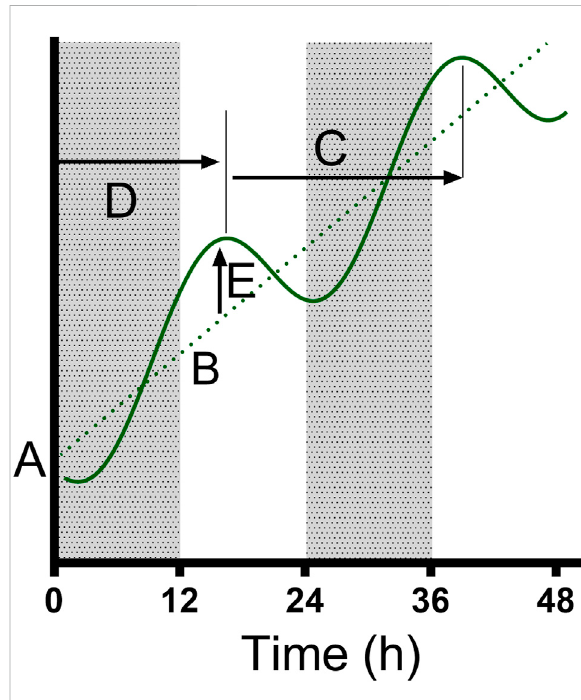
FIGURE 2 The parameters fi tted to the data. We used a model where a cosinor (solid curve) oscillates around a line (dotted line); the model was classi fi ed by the initial value (A) and gradient (B) of the line y = Bx + A, as well as the period (C) , Acrophase (time to fi rst peak, (D) and amplitude (E) of the cosinor. Where a cosinor was not preferred to a straight line, only the preferred parameters of the straight line were recorded. The model was able to identify “ damped ” cosinors with variable amplitude across the 48 h period.